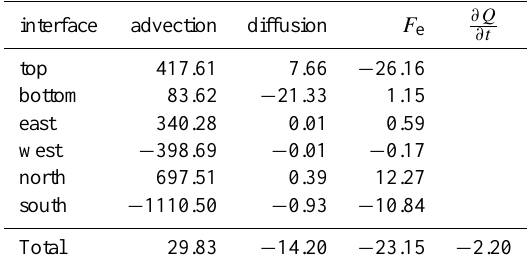
Table 1. Heat fluxes averaged over the year at each interface of the region north of the Equator. The columns show the heat fluxes due to advection and diffusion, both calculated from the 5-day mean datasets, and the estimate F e of the error in the advective flux due to ignoring high frequency fluctuations. The last column shows the ac- tual mean rate of change of heat content during the period. Positive signs indicate flux into the region. Units areTW (10 12